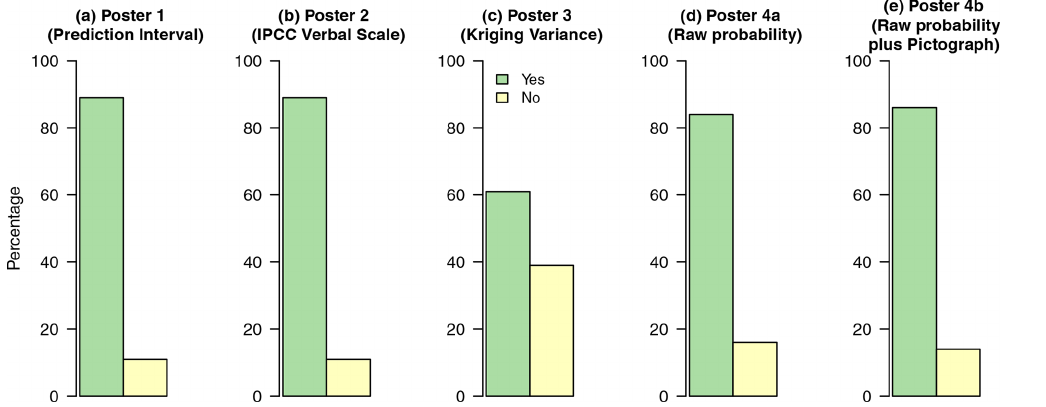
Figure 5. Bar charts showing how participants responded to how each poster helped them understand uncertainty in the spatial predictions (Q6).